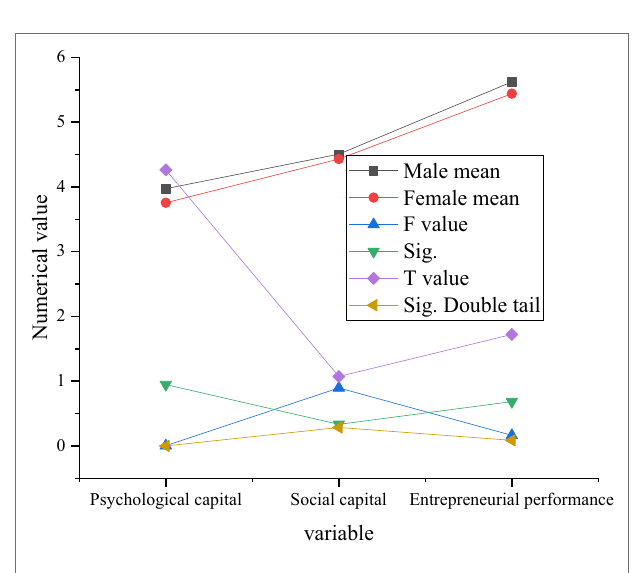
FIGURE 9 | Independent sample T -test